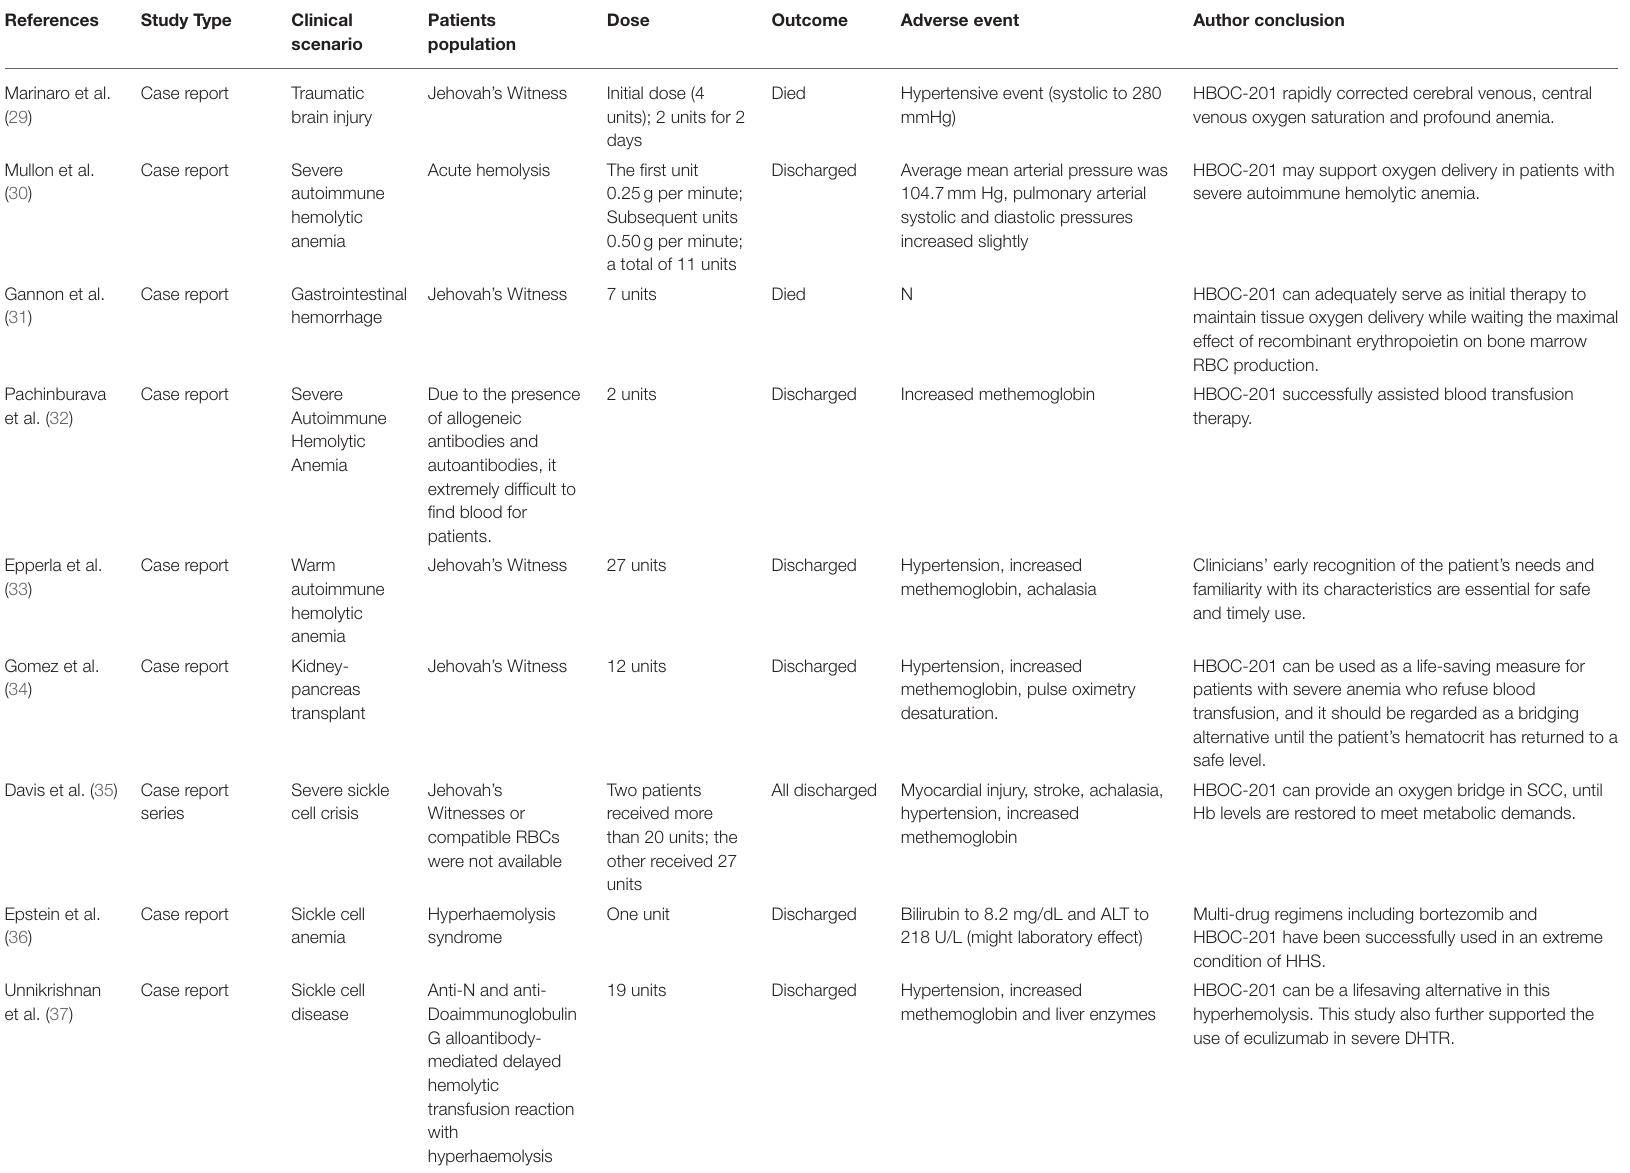
TABLE 2 | Summary of cases report of